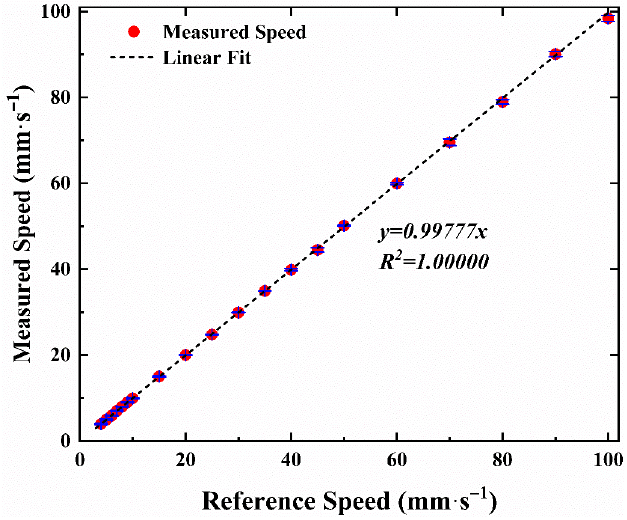
Figure 7. The measured velocity against the reference velocity of the slide rail in the range of 4 mm·s −1 to 100 mm·s −1 (R 2 = 1.00000).